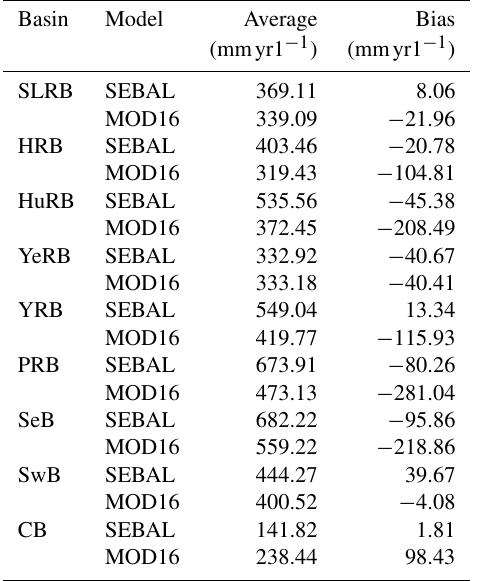
Table 2. The performance of the ET estimation of RS-based models at the basin scale.